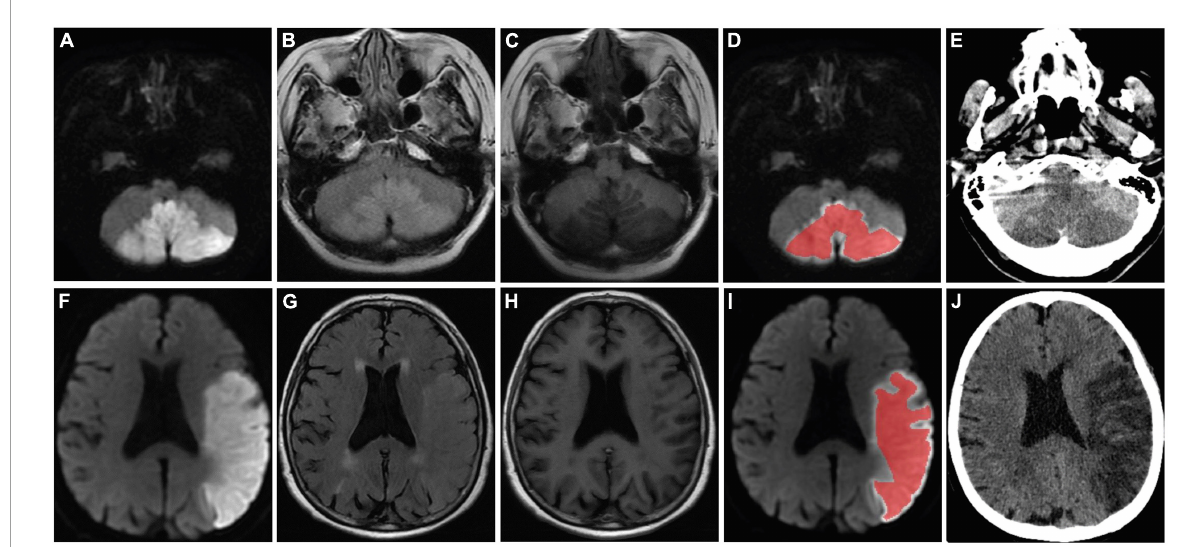
FIGURE2 MR images of two patients (a 58-year-old female patient in no-HT group and a 75-year-old female patient who developed HT) with acute MCI. The stroke lesions of the two patients were visible as hyperintensity on DWI (A,F) and T2/FLAIR (C,H) , and hypointensity signal on T1-weighted imaging (B,G) , respectively. Regions of interest were placed within the infarct lesion (D,I) and were manually delineated to include the largest stroke lesion area (red curve). Follow-up CT was performed 72 h after the MR imaging and showed no evidence of HT (E) . Follow-up CT revealed infarcts with HT in the left cerebral hemisphere (J) . HT, hemorrhagic transformation; MCI, massive cerebral infarction; MR, magnetic resonance; DWI, diffusion weighted imaging; T2/FLAIR, T2-weighted-fluid-attenuated inversion recovery; CT, computed tomography.